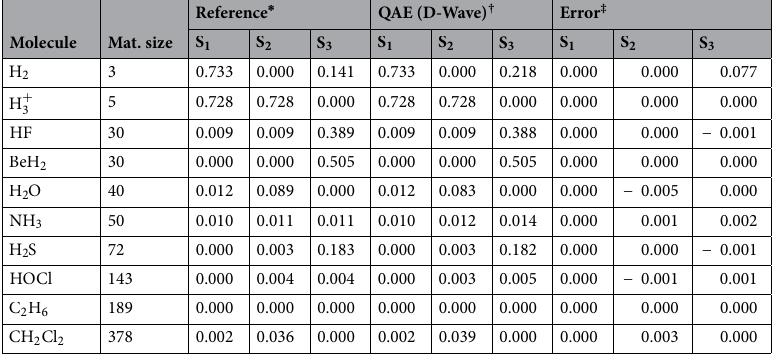
Table 4. Singlet TDDFT oscillator strengths (unitless). ∗ Reference calculation on CPU using unmodified PySCF. † PySCF was modified to use the QAE and D-Wave 2000Q. ‡ Difference between the two types of calculations.